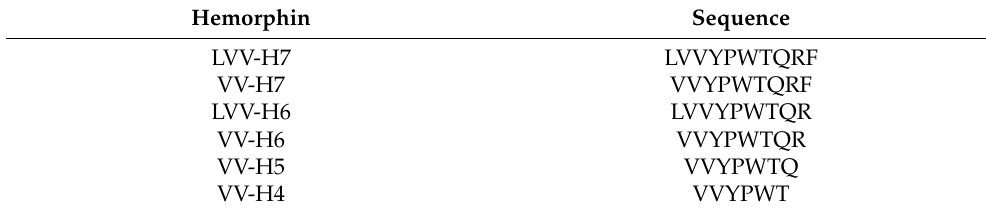
Figure 1. Scheme representing the release of opioid peptides from hemoglobin β chain. Table 1. Amino acid sequences of